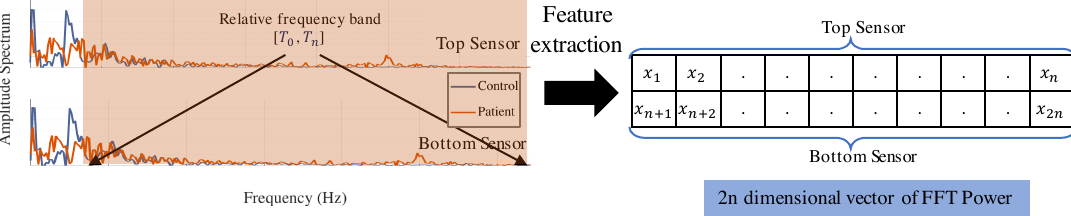
Figure 6. Frequency domain representation of angular rate from the upper sensor and formation of the feature vector with information from the lower